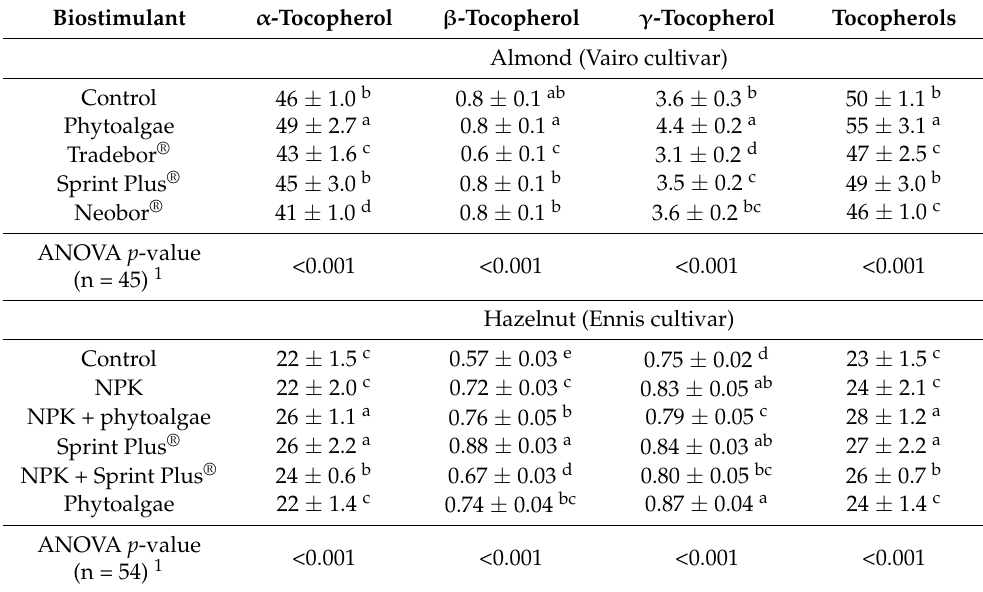
Table 3. Tocopherols profile (mg/100 g fw) for almond and hazelnut cultivars submitted to different plant biostimulants